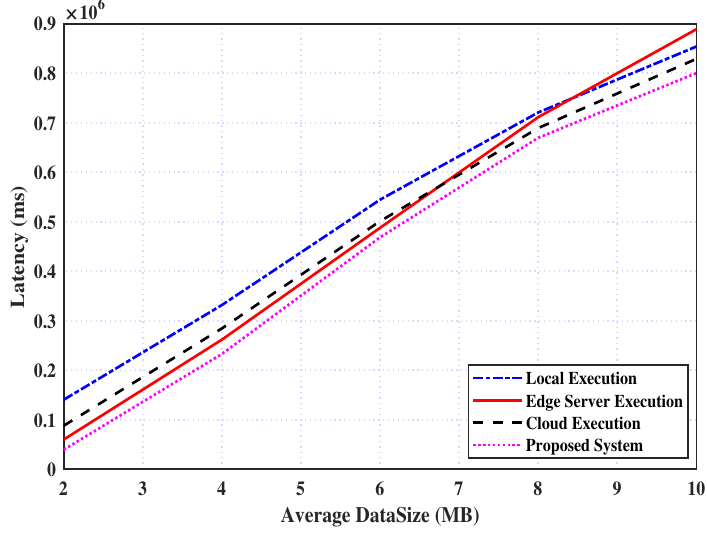
Figure 6. Latency comparison under different values of input data size.